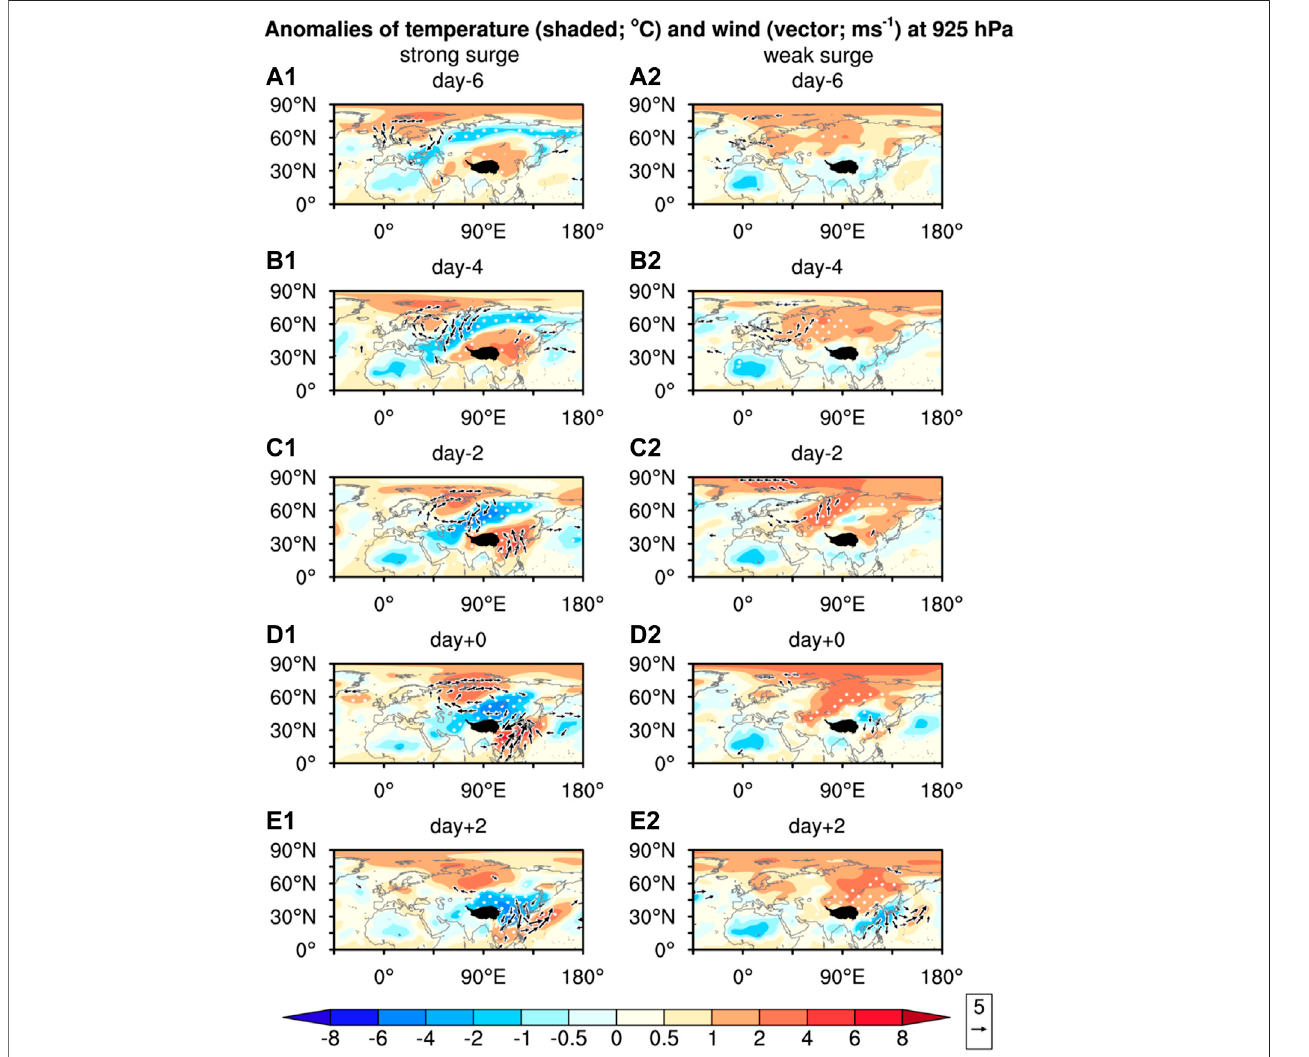
FIGURE6| Asin Figure5 ,butforthecompositeanomaliesofairtemperature(shaded; ° C)andwind(vector;ms − 1 )at925 hPa.Whitedotsandvectorsindicatethe anomalies signi fi cantly different from the climatological cold surge at the 95% con fi dence level using the two tailed Student ’ s t -test.